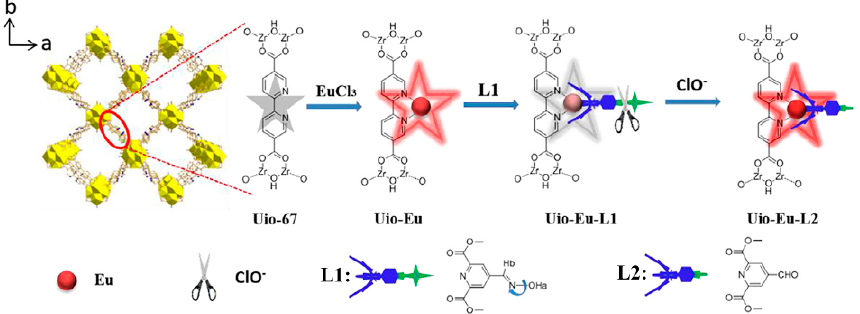
Figure 14. The structure and sensing mechanism of Uio-Eu-L1 for ClO - . Reproduced